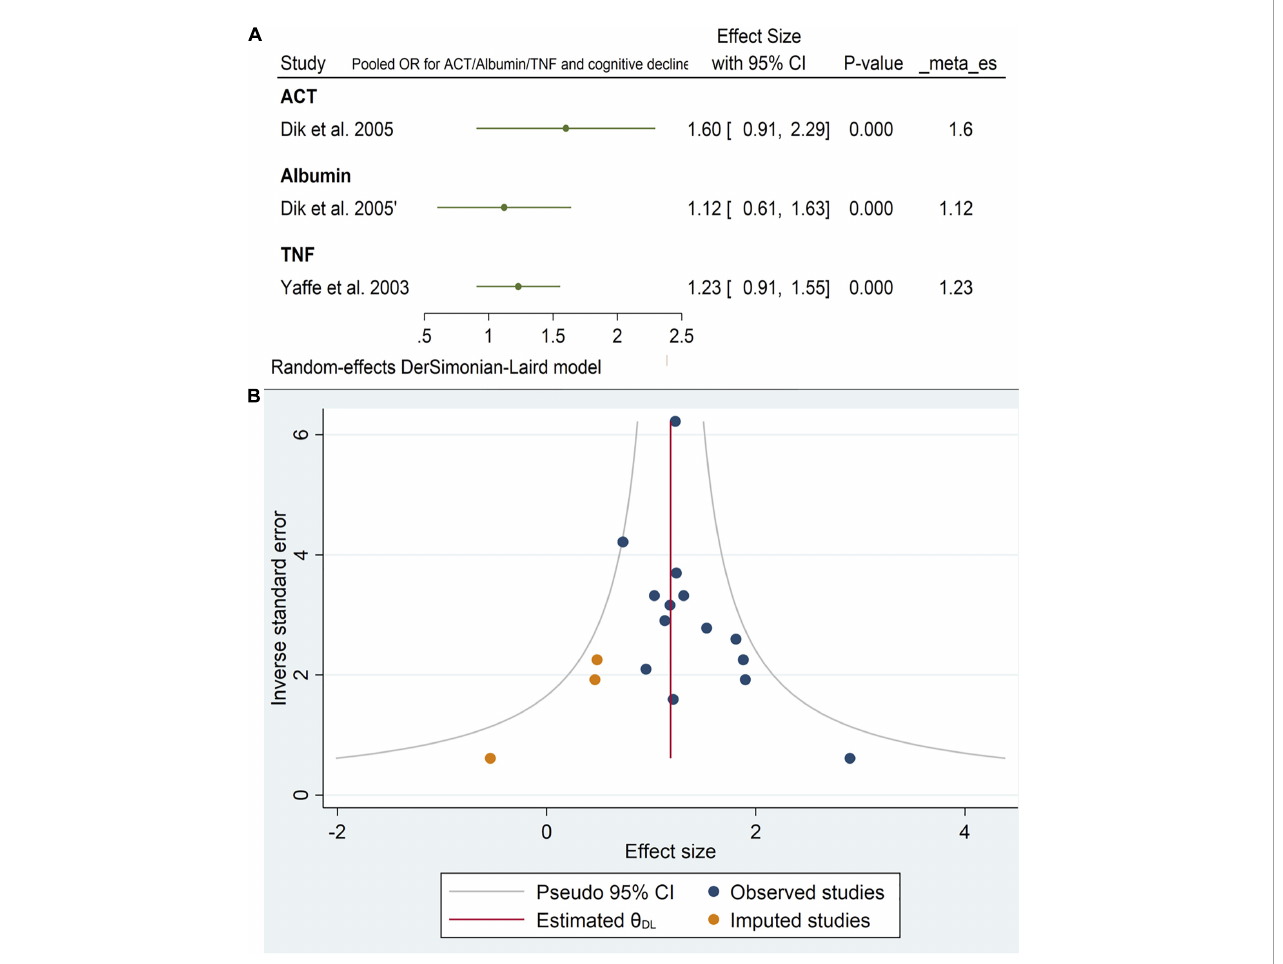
FIGURE12 (A) Forest plot of pooled odds ratio (OR) for antichymotrypsin (ACT), albumin, tumor necrosis factor (TNF), and cognitive decline. (B) Funnel plot for the included longitudinal studies for interleukin-6 (IL-6) levels (intermediate and